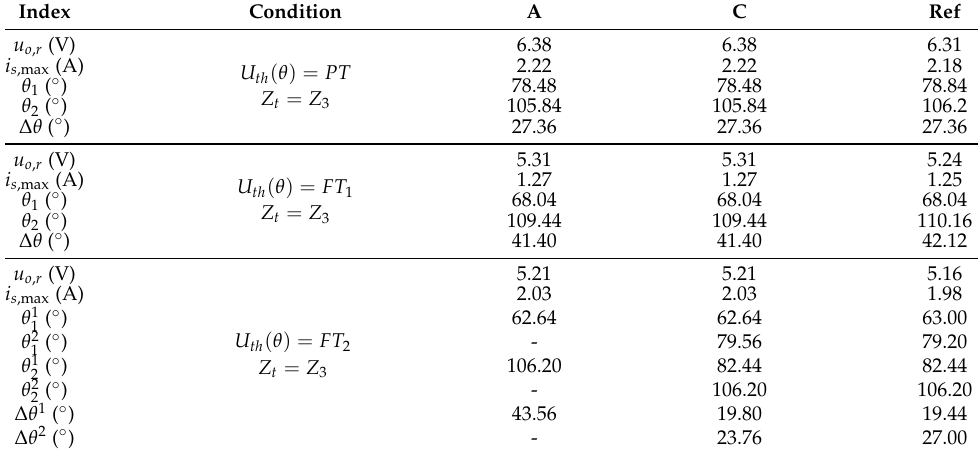
Table 6. Time-domain results obtained for different voltage